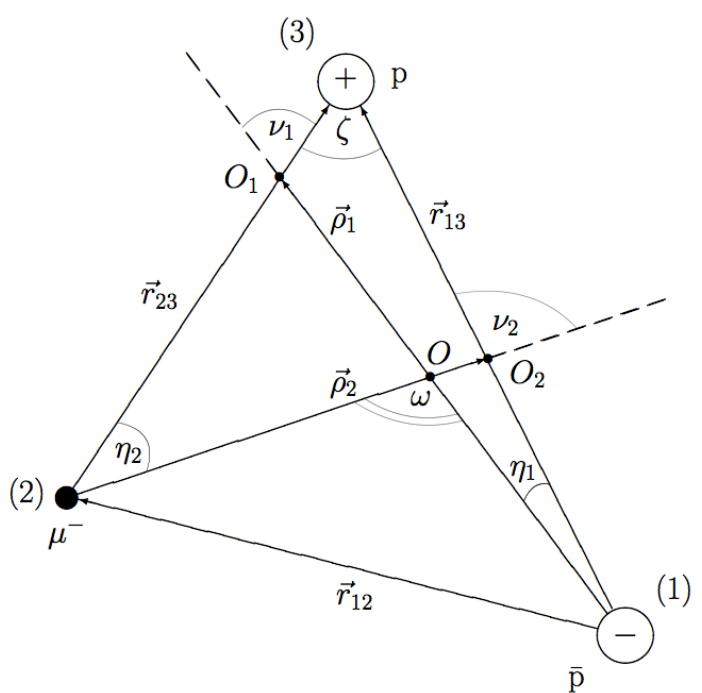
Figure 2. Configurational triangle (cid:52) 123 of the three-body system ¯p, µ − and p + is presented in this figure together with the few-body Jacobi coordinates (vectors): { (cid:126) ρ 1 , (cid:126) r 23 } and { (cid:126) ρ 2 , (cid:126) r 13 }, (cid:126) r 12 is the vector between two negative particles in the system. The angles between the vectors such as η 1 ( 2 ) , ν 1 ( 2 ) , ζ and ω are also depicted